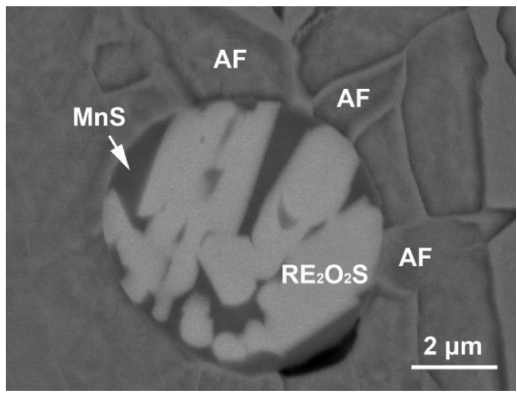
Figure 9: Acicular ferrite formation on rare earth inclusion in HAZ of steel No.2.